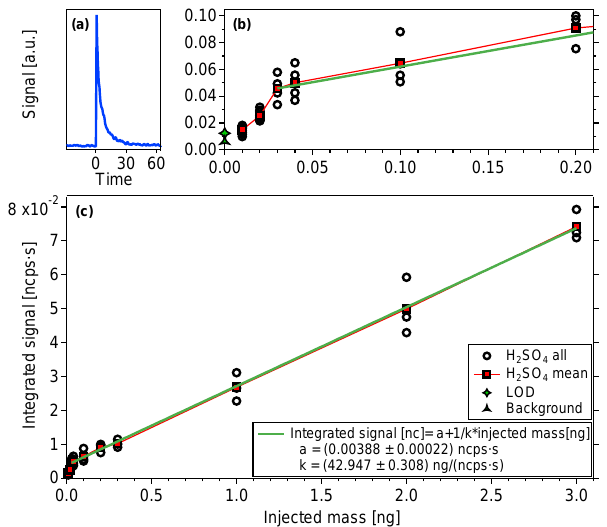
Figure 7. Sample mass calibration with (a) typical desorption shape of signals, (c) integrated signal vs. injected mass, and (b) zoom on lower masses with detection